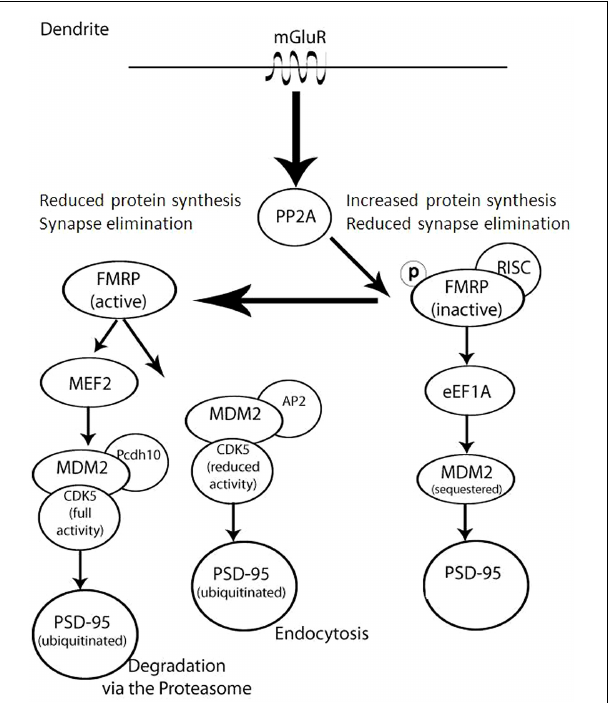
FIGURE 2 | Complex regulation of FMRP and Dlg4/PSD-95 in dendrites occurs as a result of coordinating translation, degradation, and cellular trafficking. This model illustrates that in the absence or inactivation of FMRP (right) there is an increase in synaptic protein synthesis and a decrease in synaptic elimination, since PSD-95 is not sequestered or degraded. Upon mGluR activation of PP2A, FMRP dephosphorylation (left) leads to synapse elimination as PSD-95 is either degraded or trafficked out of the